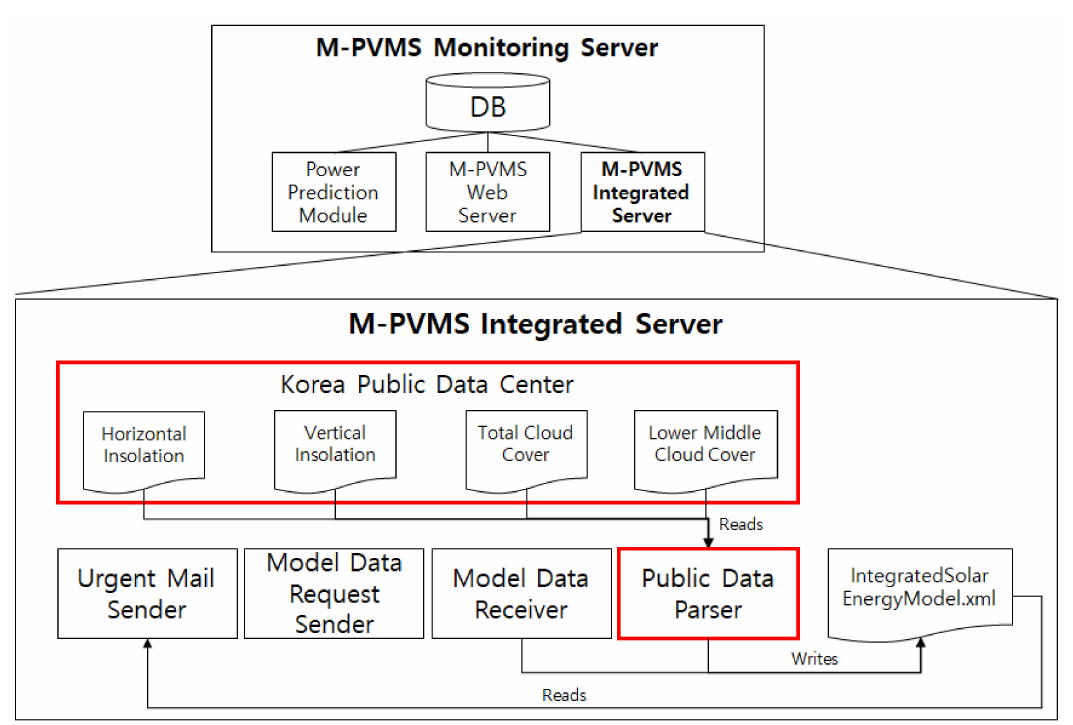
Figure 8. Improved structure of M-PVMS integrated